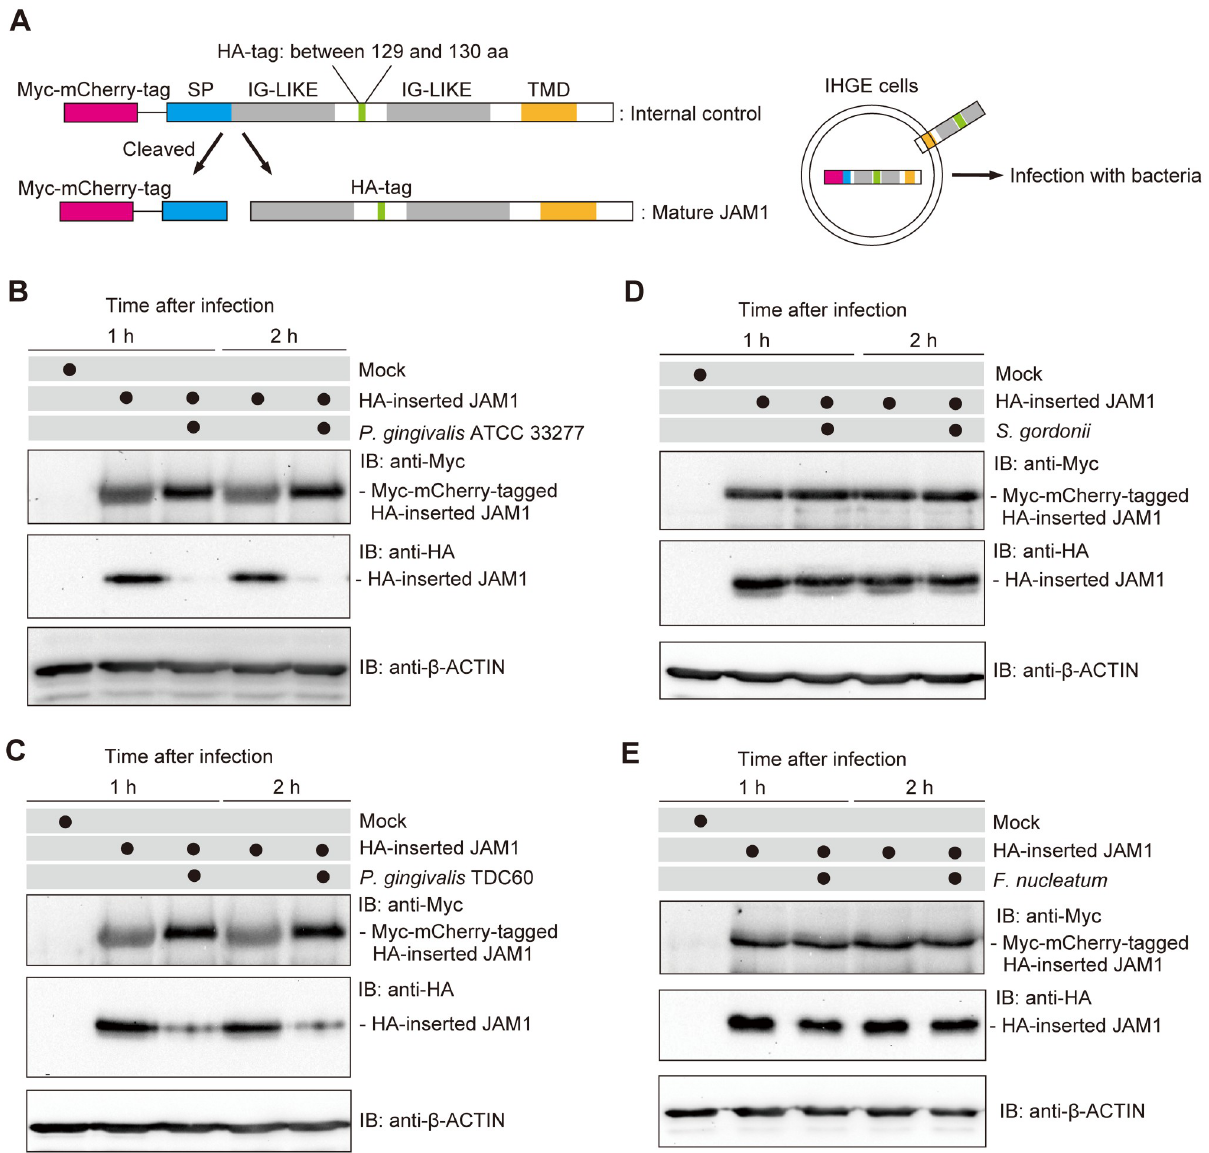
Fig 4. P . gingivalis , but not S . gordonii or F . nucleatum , degrades JAM1 in IHGE cells. (A) Schematic view of the structure of Myc-mCherry–tagged HA-inserted JAM1. The immature form of Myc-mCherry–tagged HA-inserted JAM1 was used as an internal control to monitor degradation flux of the mature form of HA-inserted JAM1. IHGE cells were transiently transfected with Myc-mCherry–tagged HA-inserted JAM1 plasmid. Following 48 h of incubation, cells were infected for 1 or 2 h with the indicated bacteria at an MOI of 100. The cells were then analyzed by immunoblotting using the indicated antibodies. (B – E) IHGE cells were transiently transfected with the HA-inserted JAM1 plasmid. Following 48 h of incubation, the cells were infected with P . gingivalis ATCC 33277 (B), P . gingivalis TDC60 (C), S . gordonii DL-1 (D), or F . nucleatum ATCC 25586 (E) at an MOI of 100 for the indicated times. The cells were then analyzed by immunoblotting with the indicated